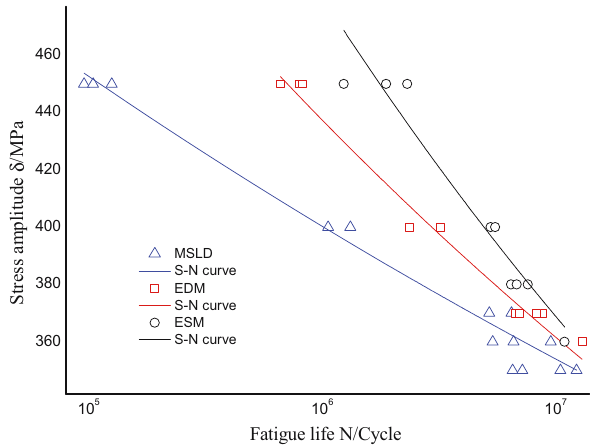
Figure 5: S – N curve of di ff erent drilling techniques specimens at 980°C.